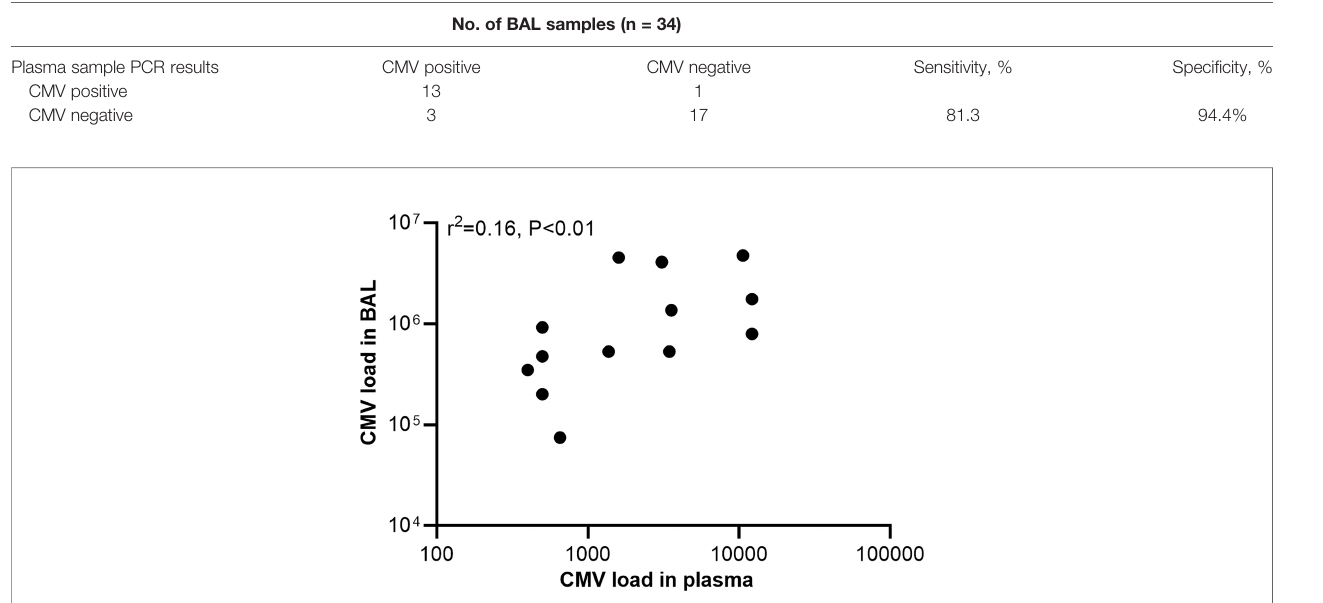
TABLE 3 | Cytomegalovirus (CMV) detection by polymerase chain reaction (PCR) analysis of bronchoalveolar lavage (BAL) and plasma samples.